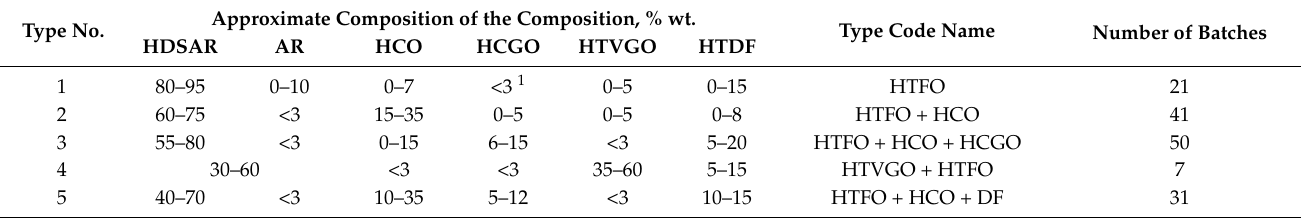
Table 3. Distribution of Singamas Petroleum batches by type